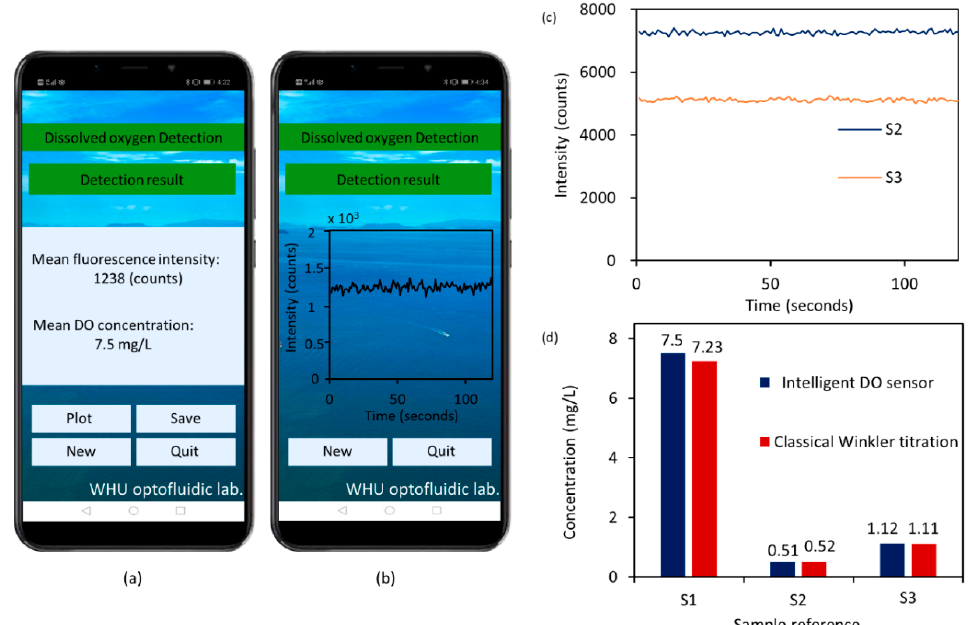
Figure 6. ( a ) The APP interface for DO detection result of the lake water sample (S1). ( b ) The APP interface shows the plot of the DO detection result for S1. ( c ) Phosphorescent intensity for S2 and S3; the data was derived from the mobile APP. ( d ) Comparison of the proposed method and reference method.